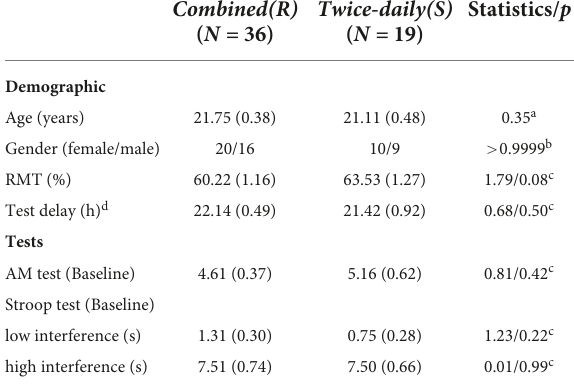
TABLE 4 Characteristics of participants from Combined(R) and Twice-daily(S) .